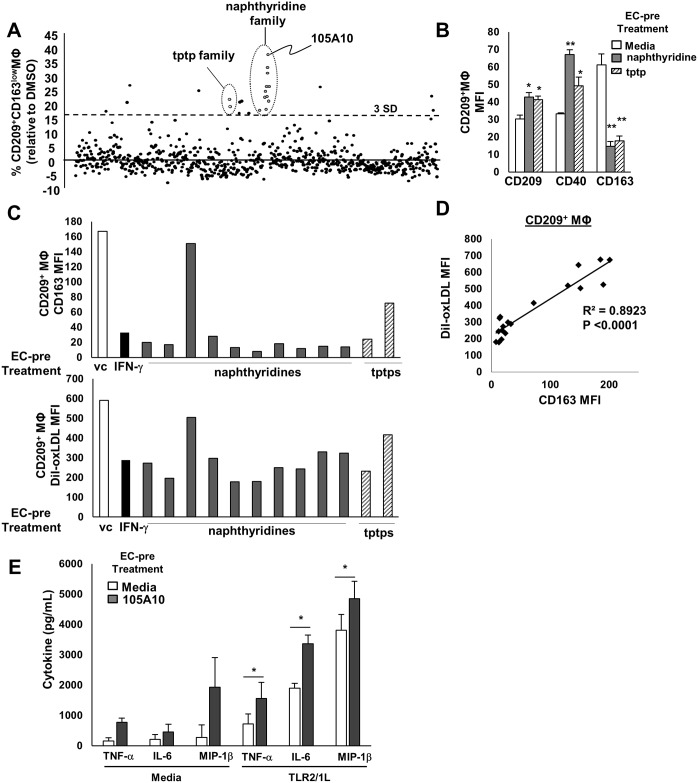
Small molecules can facilitate endothelial-driven antimicrobial MΦ.(A) Endothelial cells were treated with a small molecule library (n = 642, 10 μM) for 5 hours. EC were washed, primary mononuclear cells were added, and CD209+MΦ differentiation was assessed by flow cytometry. Polarizing compounds were selected by their capacity to drive the antimicrobial CD209+MΦ phenotype (CD209+CD163low gate). Two structural families (tptp and naphthyridine) accounted for 54% of the hits, as defined by > 3 s.d. from the mean (dashed line). (B) Phenotypic validation of active tptp and naphthyridines; data represent mean and SEM of three donors (* p value < 0.05, ** p value < 0.01). (C,D) Phagocytosis of Dil-oxLDL by antimicrobial CD209+MΦ differentiated in culture with compound-treated endothelium, and correlation between CD163 expression and DiI-oxLDL uptake. (E) TLR2/1L responsiveness by CD14+MΦ derived from resting vs. naphthyridine (105A10) treated EC. Data represent the mean +/- SEM from three independent experiments performed in triplicate wells (* p value < 0.05, ** p value < 0.01).